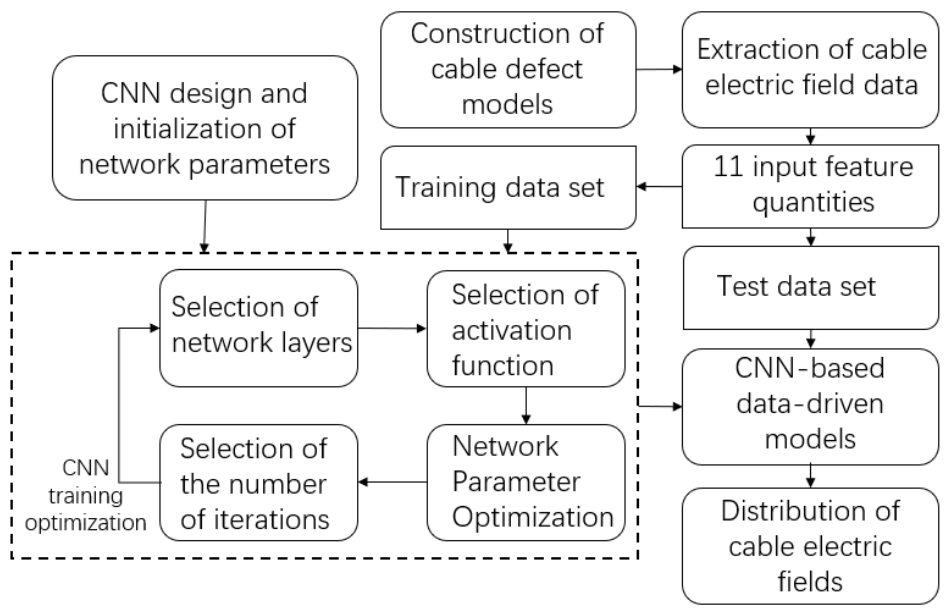
Figure 2. Flowchart of data-driven calculation based on CNN.